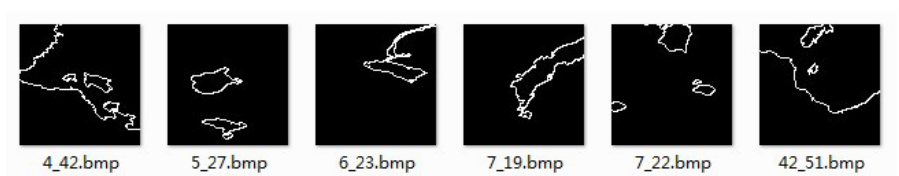
Figure 3.a. Image coastline extracted by this method